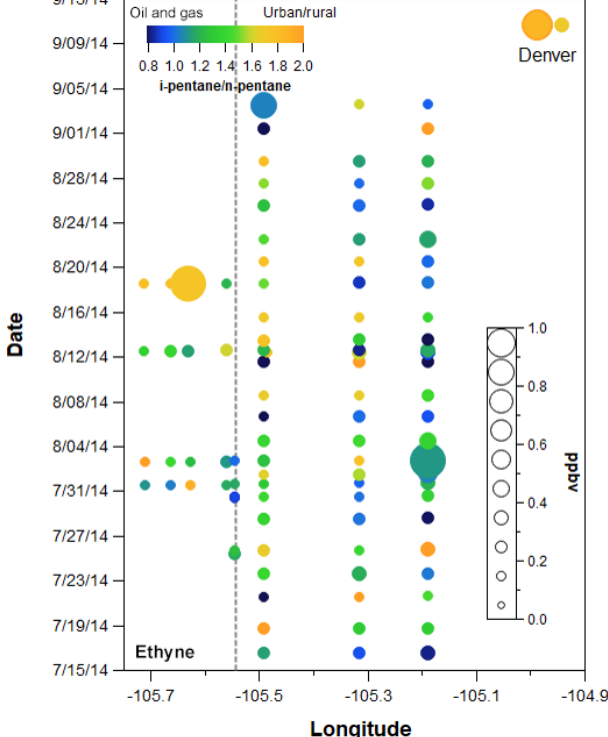
4 Ozone Figure 8. VOC canister data plotted by longitude and date with ethane mixing ratio represented by the size of each point and the i - to n -pentane represented by the color. Locations correspond to tran- sect samples shown in Fig. 2. Points to the left of the grey dashed line were taken in